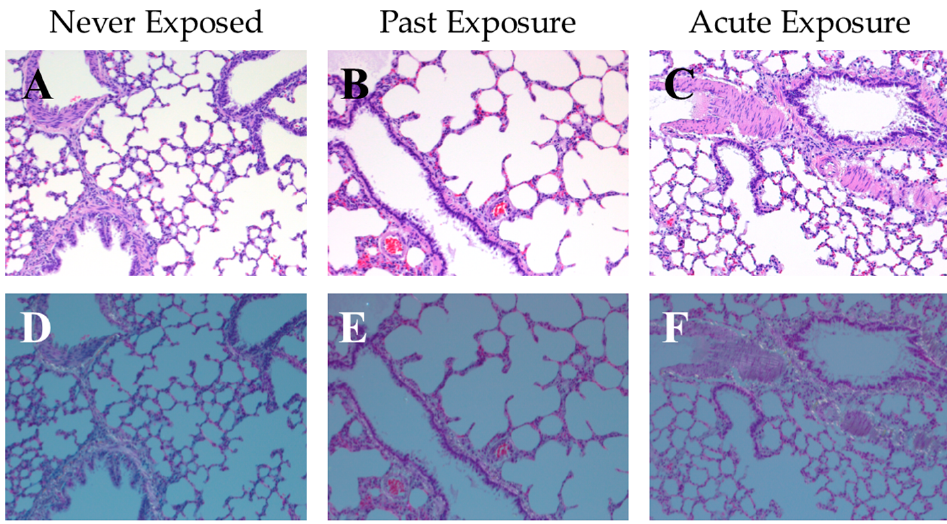
Figure 1. Representative photos of rat lung tissue at 100×; sections show an inflated area that included an arteriole, terminal bronchiole, and a larger bronchiole. ( A – C ) Hematoxylin and eosin (HE) stained tissue under bright light microscopy, and ( D – F ) corresponding HE stained tissue under polarized light. ( A and D ) tissue from a naïve rat that were never exposed to hydrophobic sand (“Never Exposed”); ( B and E ) tissue from a rat that underwent all LabSand experimental sessions, and was euthanized 1 month after the conclusion of the experiment with no further exposure to hydrophobic sand (“Past Exposure”); ( C and F ) tissue from a rat that underwent all LabSand experimental but was also placed in a cage with hydrophobic sand for 2 h prior to euthanasia (“Acute Exposure”).